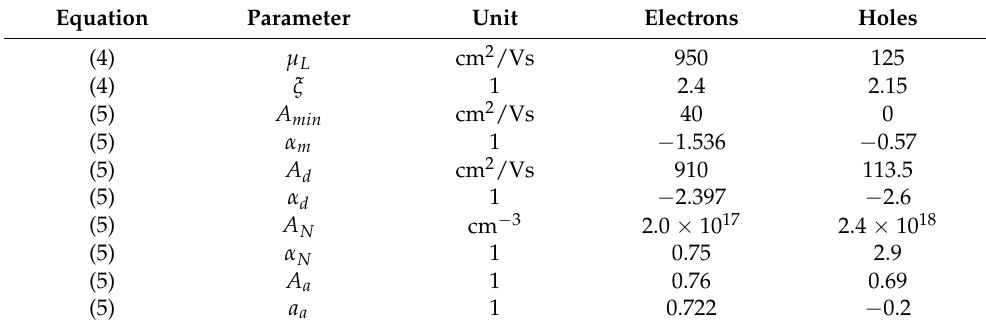
Table A1. Mobility parameters [19].